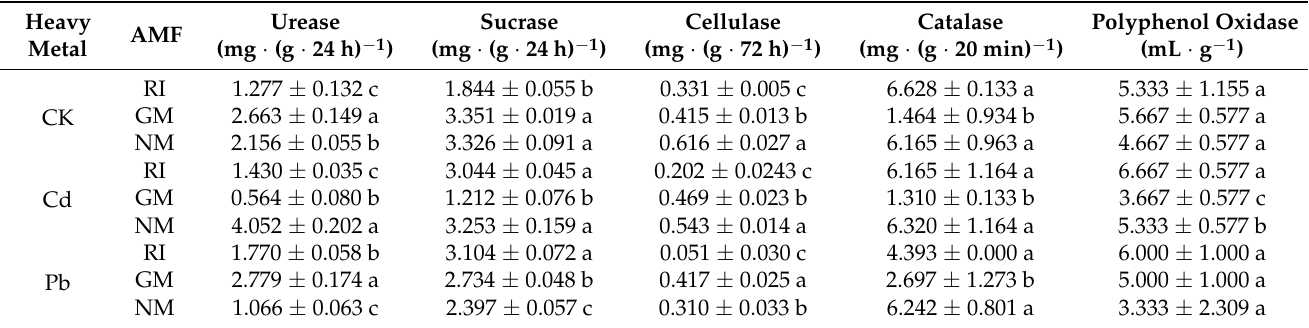
Table 4. Influence of AMF infection on the enzyme activities of litter under heavy metal stress.